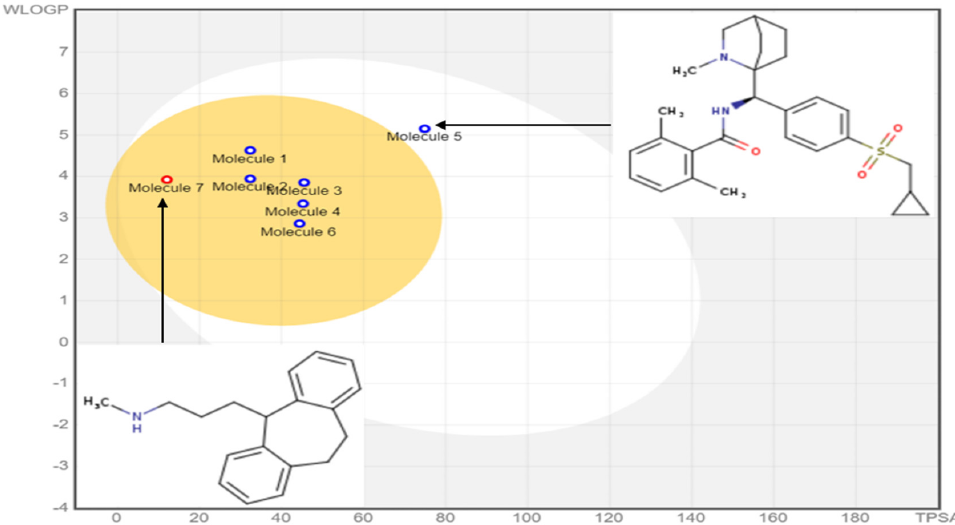
Figure 6. BOILED-egg predictive model of the most active ligands. Table 9. Prediction of ADMET pharmacokinetic properties of nortriptyline and more active